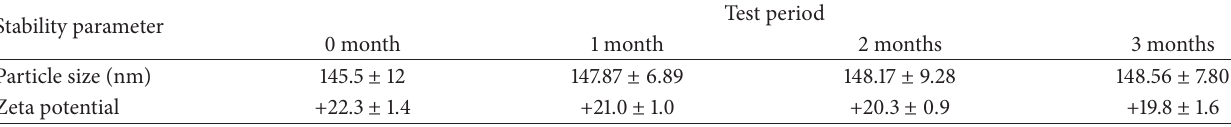
Table 7: Stability characteristics of cyclosporine loaded NPs in terms of mean particle size and zeta potential.